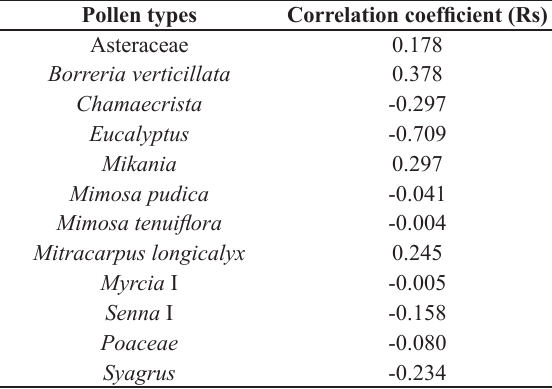
The correlation (Spearman coeffi cient) between the levels of phenolic compounds and the concentration of the main pollen types of the territory of the Agreste of